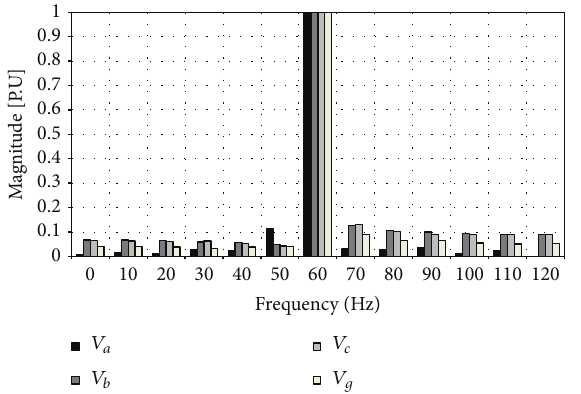
Figure 9: Failure currents: phase A to ground.